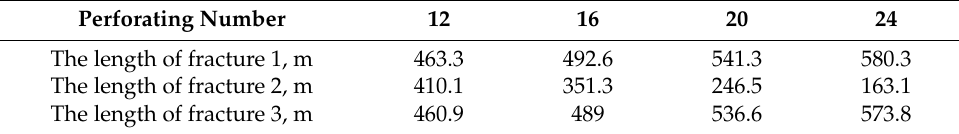
Figure 6. Effects of different perforations per cluster on the fracture geometry: ( a ) 12; ( b ) 16; ( c ) 20; and ( d ) 24. Table 3. The results of fracture length affected by different perforating numbers.